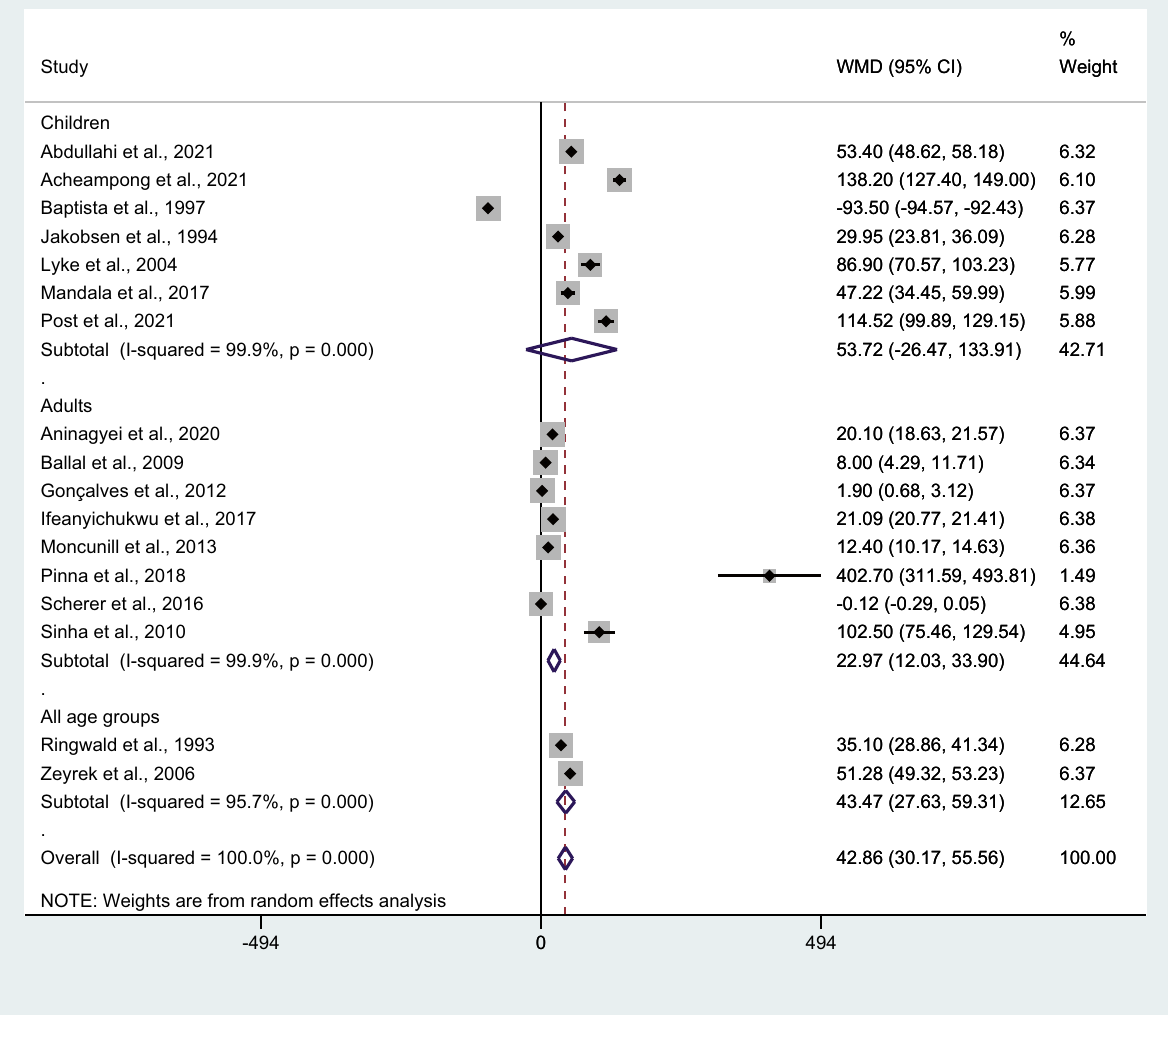
Figure 10. Differences in IL-6 levels between patients with uncomplicated malaria and controls by age groups. Abbreviation: WMD, weighted mean difference; CI, confidence interval; black diamond symbol, point estimate; solid line in the middle of the graph at 0, zero effect size; Dashed red line: pooled WMD between the two groups; I 2 , level of heterogeneity; P = 0.000 or less than 0.05, significant